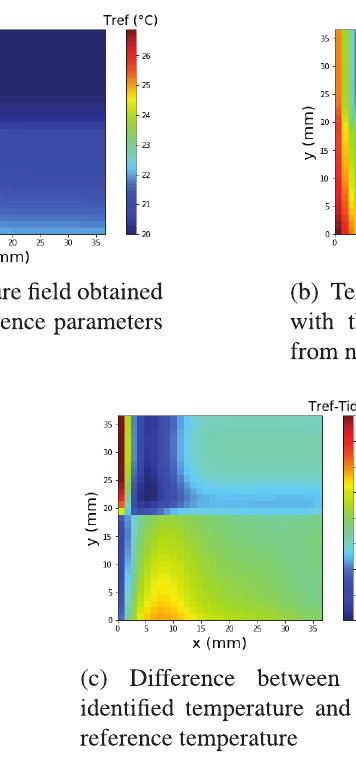
Fig. 11. Comparison between reference temperature field (a) and the temperature field calculated with the identified parameters from noisy ( σ = 0 . 4 ◦ C) temperature field (b) gap between the two fields (c), of CRFP-PA materials at time t = 80 s and M = 30